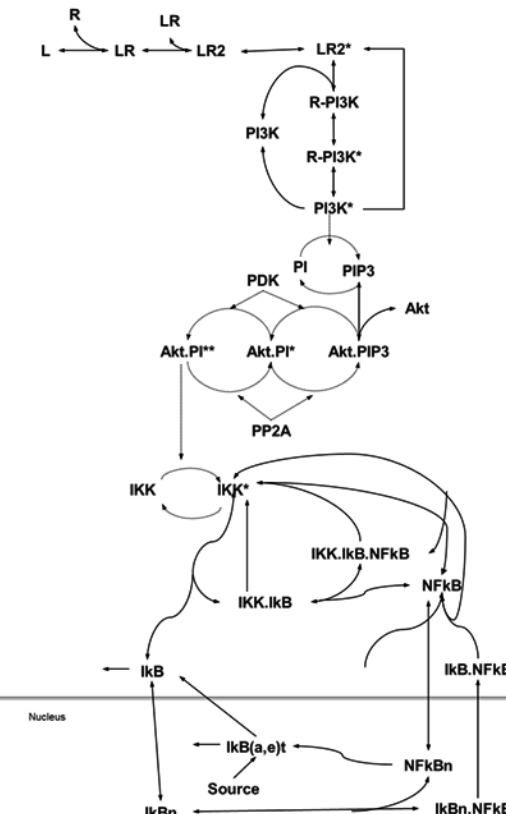
Figure 1. Biochemical reactions of the phosphatidylinositol 3’ ‐ OH kinase (PI3K) ‐ Akt and Nuclear Factor ‐ kappaB (NF ‐κ B) pathway and its modularization. Modularization is based on the biological functionality and contiguity, where modeling biochemical reactions of the pathways via mass action law and Michaelis–Menten approximation (receptor) yields a nonlinear ordinary differential equation (ODE) model. Details are provided in the Materials and Methods section.